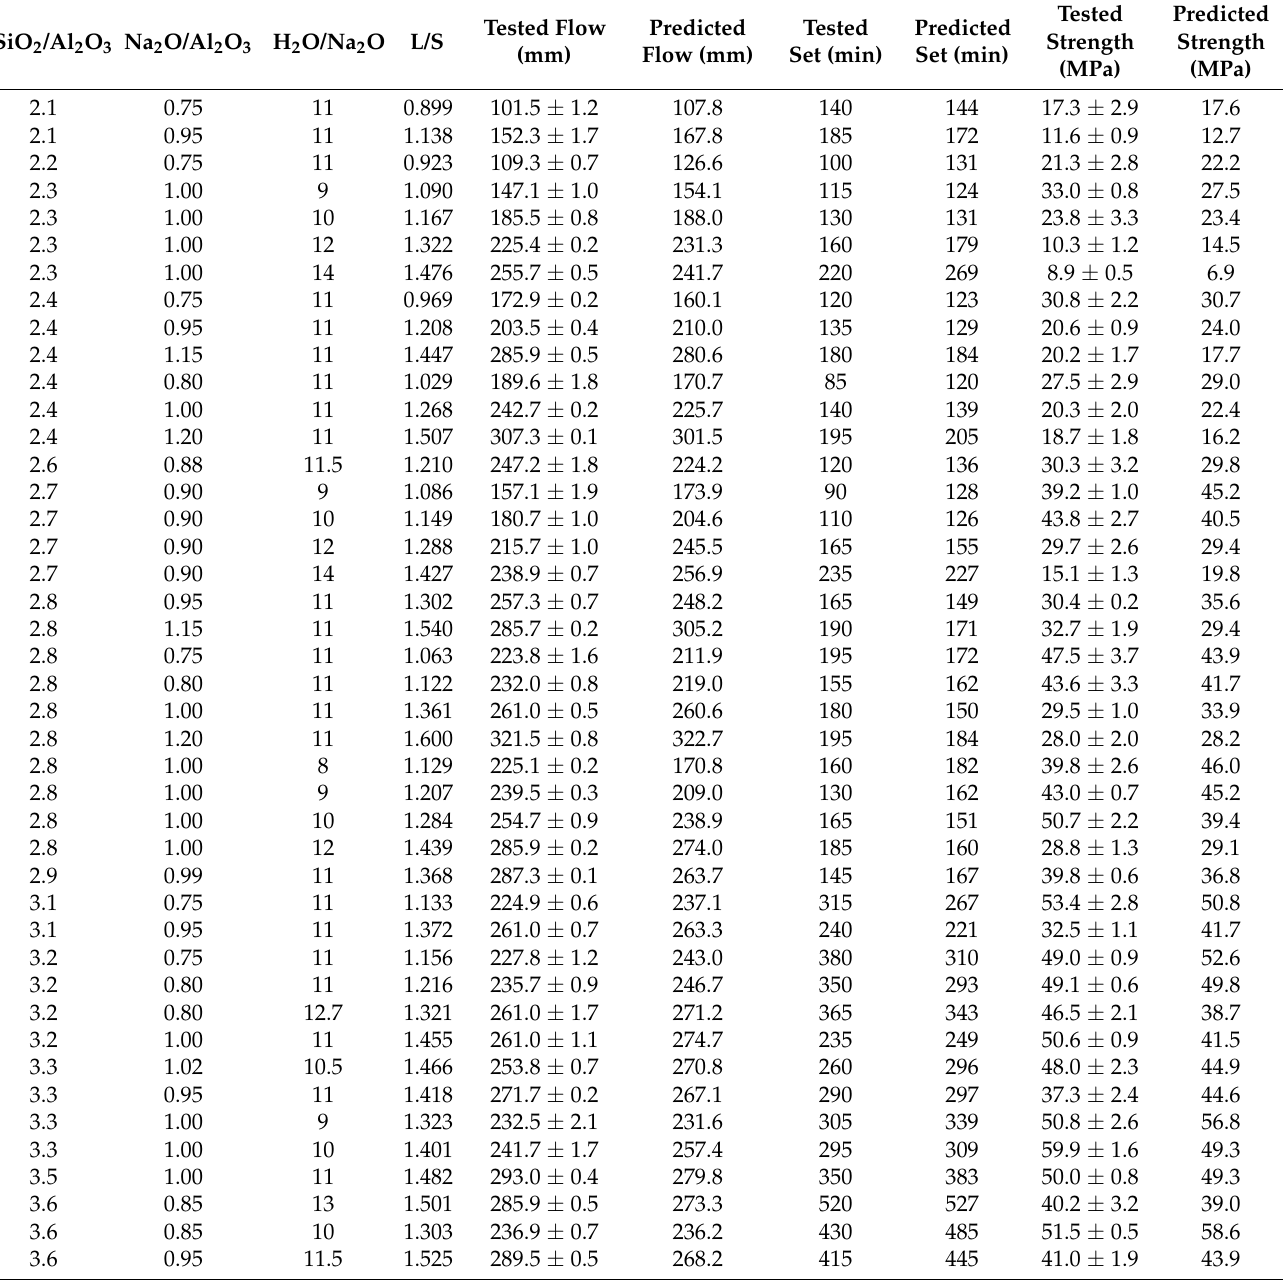
Table 5. Training dataset for establishing multi-factor models and predicted